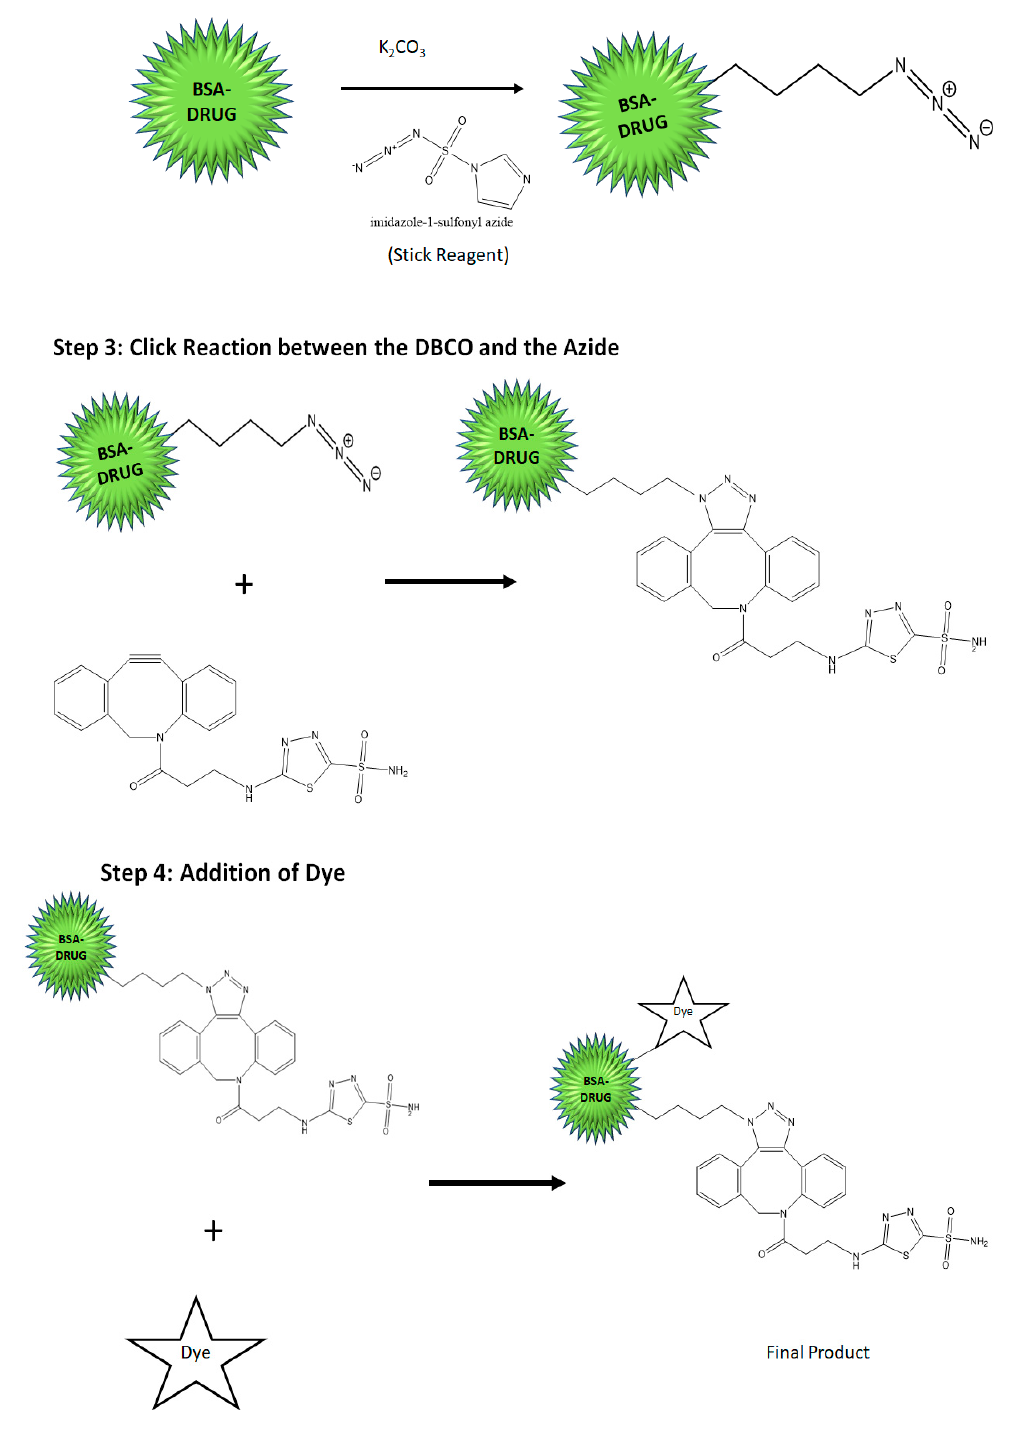
Figure 3. Scheme for the synthesis of the BSA-CDF-ATZ nanoparticle using click chemistry. This scheme illustrates the steps involved in the synthesis of the a theranostic nanoparticle guided by CA IX for cell killing in